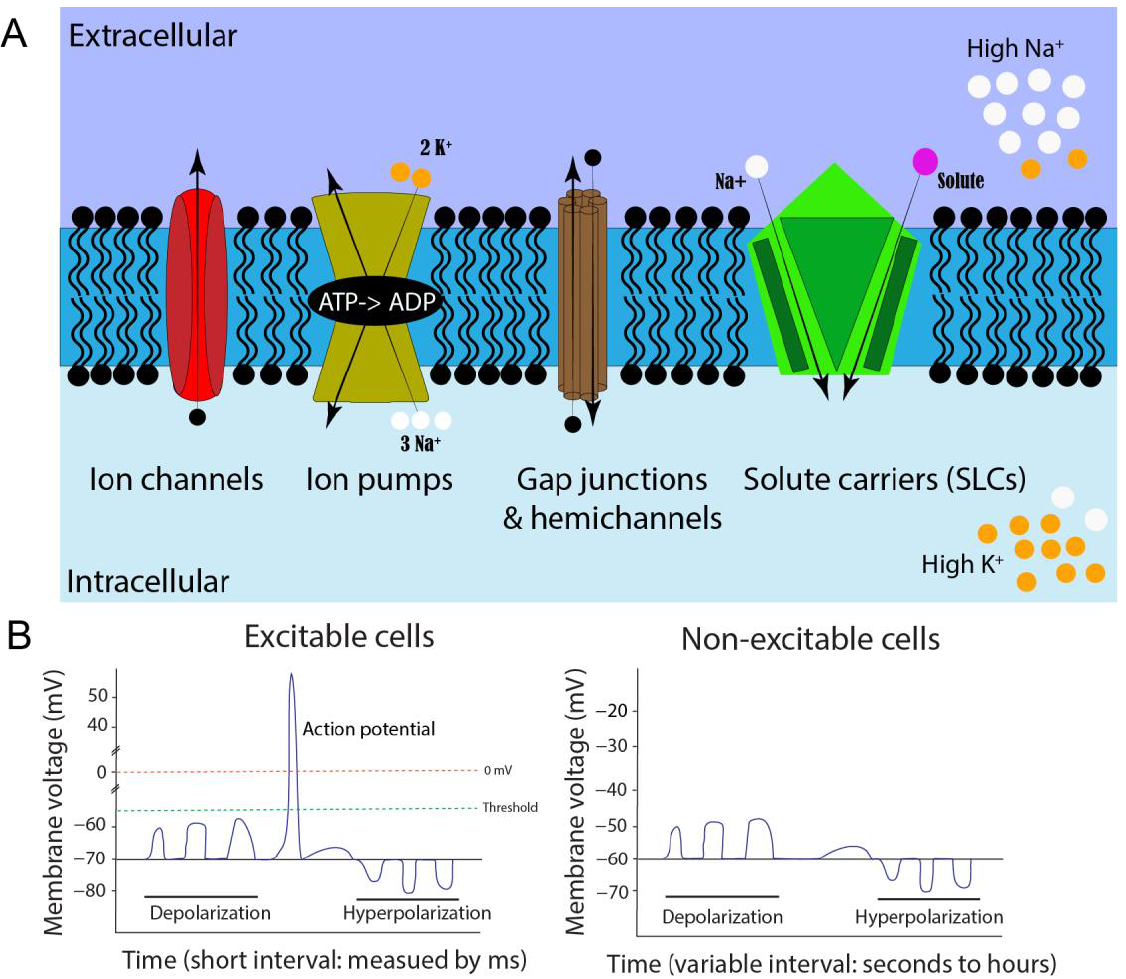
Figure 1. Cell membrane potential formation and comparison of neuromuscular excitable cells and non-excitable somatic cells. ( A ). Illustration of resting membrane potential, ion regulators, and ionic concentrations when the cell is in a non-excitable state. Different shapes represent various ion regulators on a cell membrane (blue region). The arrows indicate the movement of ions when the regulators are open. ( B ). Comparison of neuromuscular excitable and non-excitable somatic cells. Excitable cells usually exhibit action potentials, while the non-excitable somatic cells have membrane potential fluctuations, which vary in their amplitudes and frequencies.